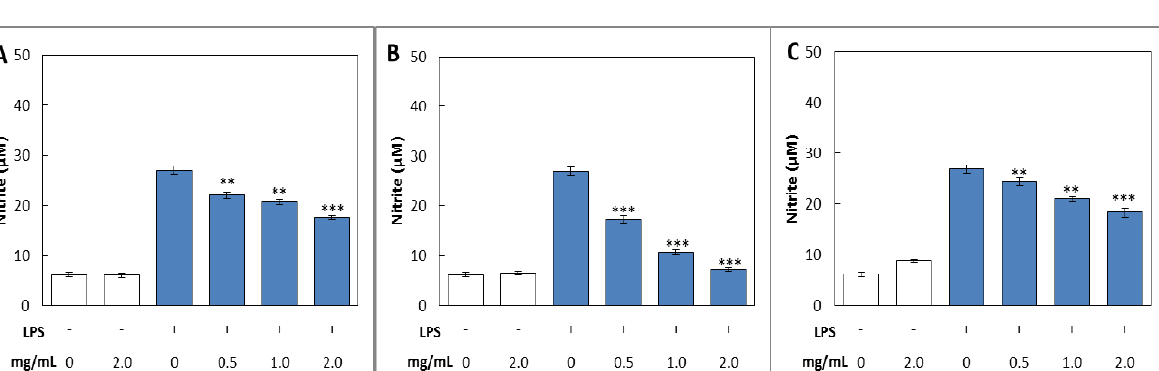
Figure 4. Inhibitory effects of various extracts from fruiting bodies of Pleurotus florida on LPS-induced nitrite production in RAW 264.7 cells. ( A ); methanol extract, ( B ); acetone extract and ( C ); hot-water extract. Accumulated nitrite in the culture medium was determined by the Griess reagent. The values are expressed as ± SD ( n = 3). *** p ≤ 0.001; ** p ≤ 0.01 vs . group treated with LPS